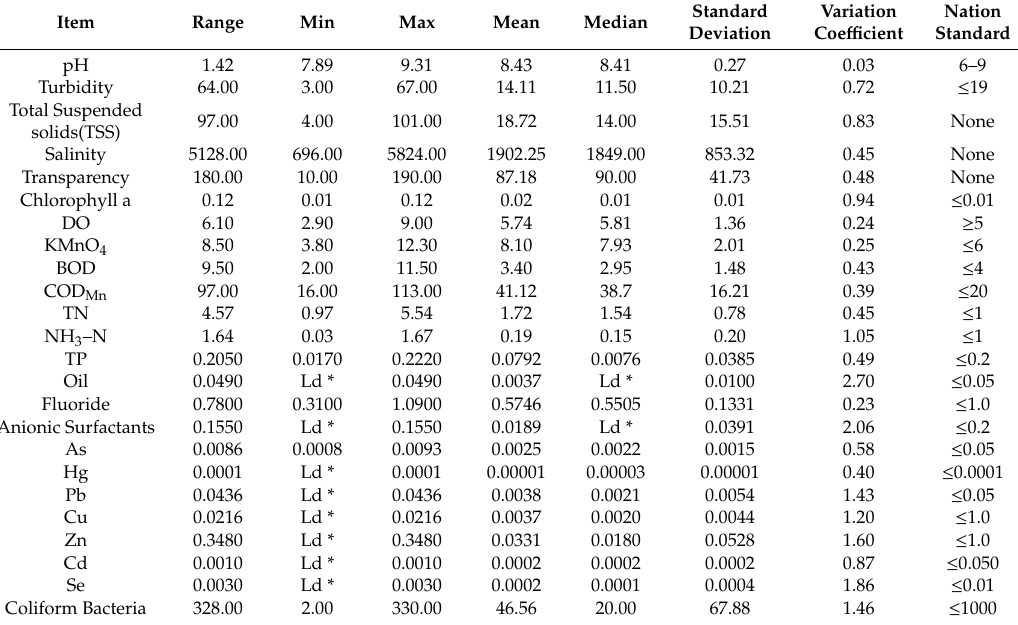
Table 3. Descriptive statistics of water quality factors in Wuliangsuhai